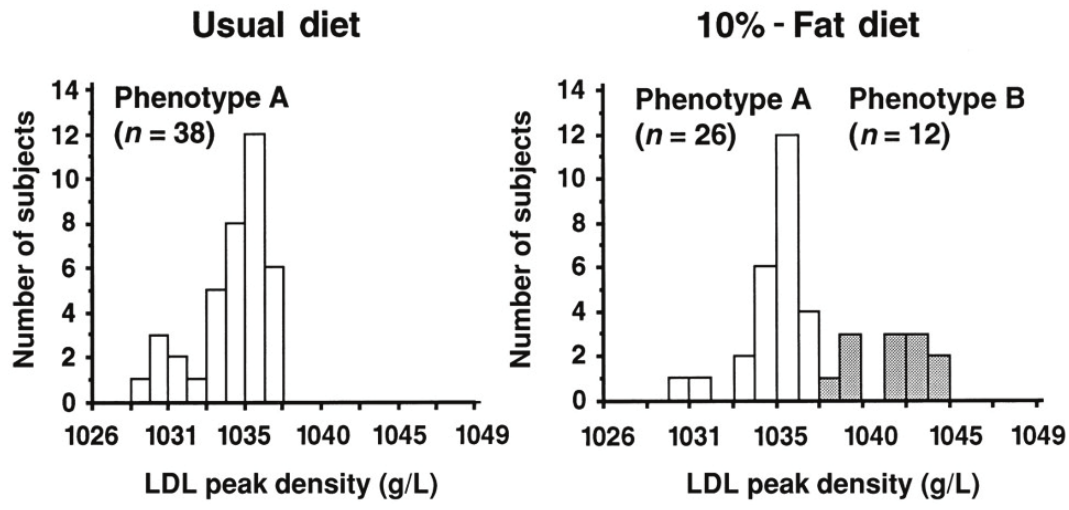
Figure 3. Distribution of LDL peak particle densities determined by analytic ultracentrifugation in 38 men consuming their usual diet ( (cid:2) 32% fat) and a 10% fat diets. White bars represent subjects with LDL subclass phenotype A and shaded bars subjects with LDL subclass phenotype B. Reprinted with permission